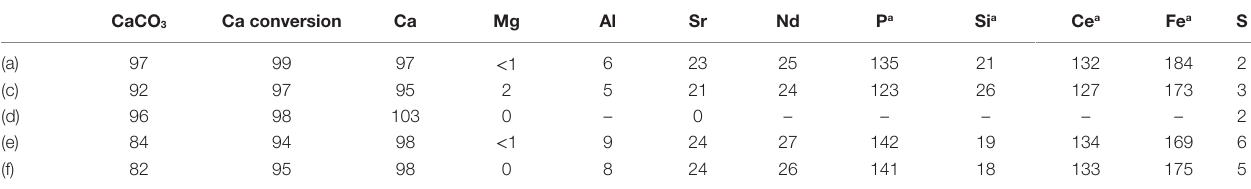
TaBle 4 | cc content of the solid products (%), ca conversion from Pg to solid cc (%), and the transfer efficiency of various elements from Pg to the solid product material (%). cacO 3